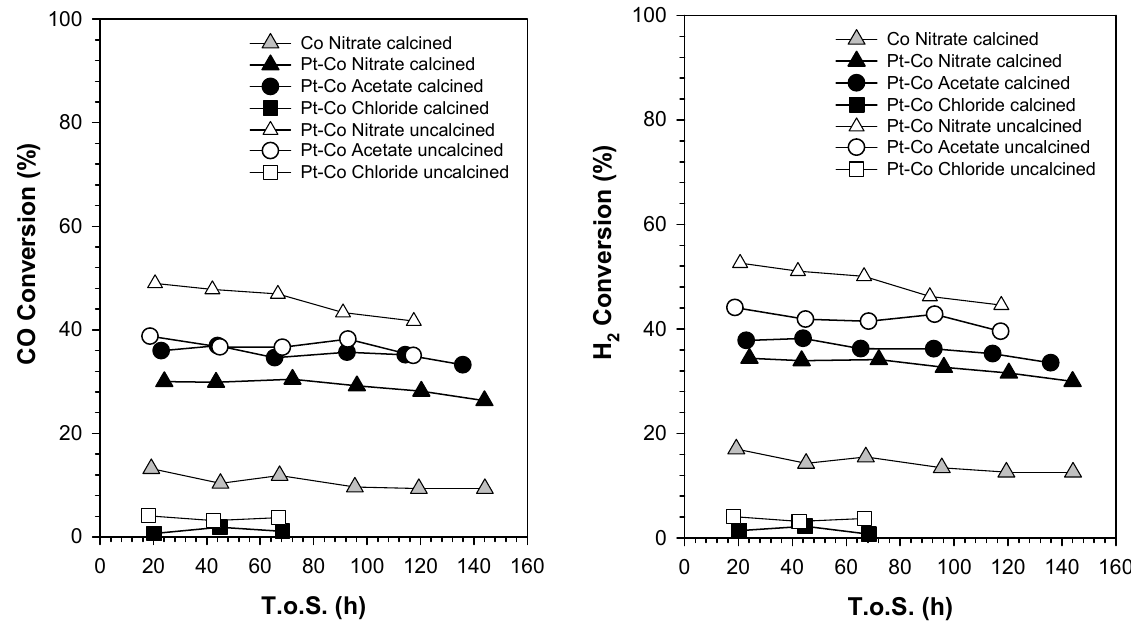
Figure 17. ( left ) CO conversion and ( right ) H 2 conversion from catalytic testing in the CSTR (T = 220 °C, P = 20 atm, H 2 /CO = 2 mol/mol, SV = 6 slph/g cat ).